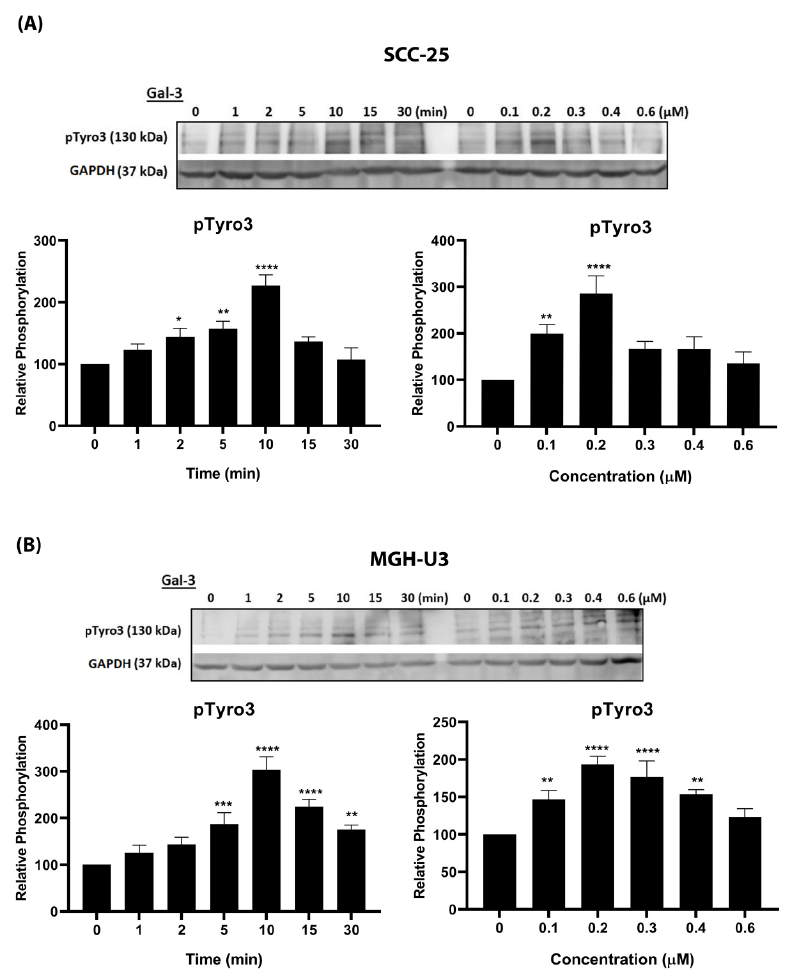
Figure 2. Effect of Gal-3 stimulation on phosphorylation of TAM receptors. ( A ) Representative Western blots showing phosphorylated Tyro3 (pTyro3) protein in SCC-25 ( A ) and MGH-U3 ( B ) cells stimulated by Gal-3 (0.2 μ M) in time-course (left) and dose response (right) experiments (9 min stimulation). Accompanying graphs show protein quantification by densitometric analysis of bands. Data are the mean ± SEM protein expression normalised against GAPDH as loading control protein; ANOVA with Tukey’s multiple comparison post-hoc analysis; **** p < 0.0001, *** p < 0.001, ** p < 0.01, * p < 0.05 versus control (time 0 or untreated) ( n = 3 separate